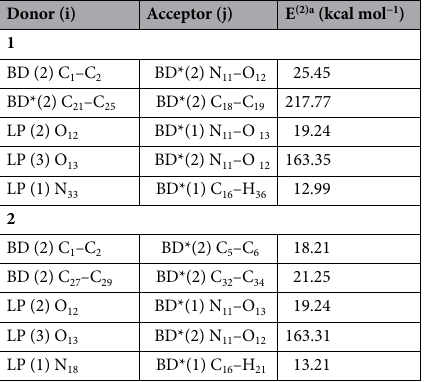
Table 8. The second-order perturbation energies E(2) associated with the delocalization of donor and acceptor bonds of 1 and 2 obtained at B3LYP/6-311G(d,p). a E (2) means energy of hyperconjugative interactions (stabilization energy).